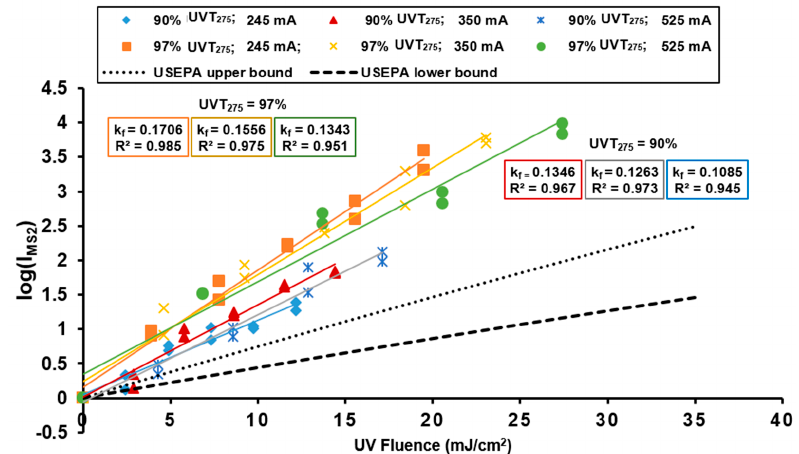
Figure 4. Comparison of UV dose–response curves for the bench-scale UV-LED reactor and